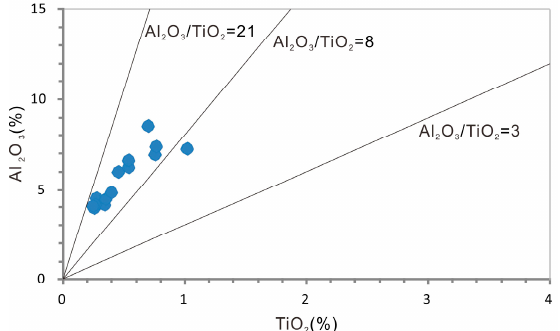
Figure 11. Al 2 O 3 vs. TiO 2 for coal samples from the Zhongliangshan Coalfield.